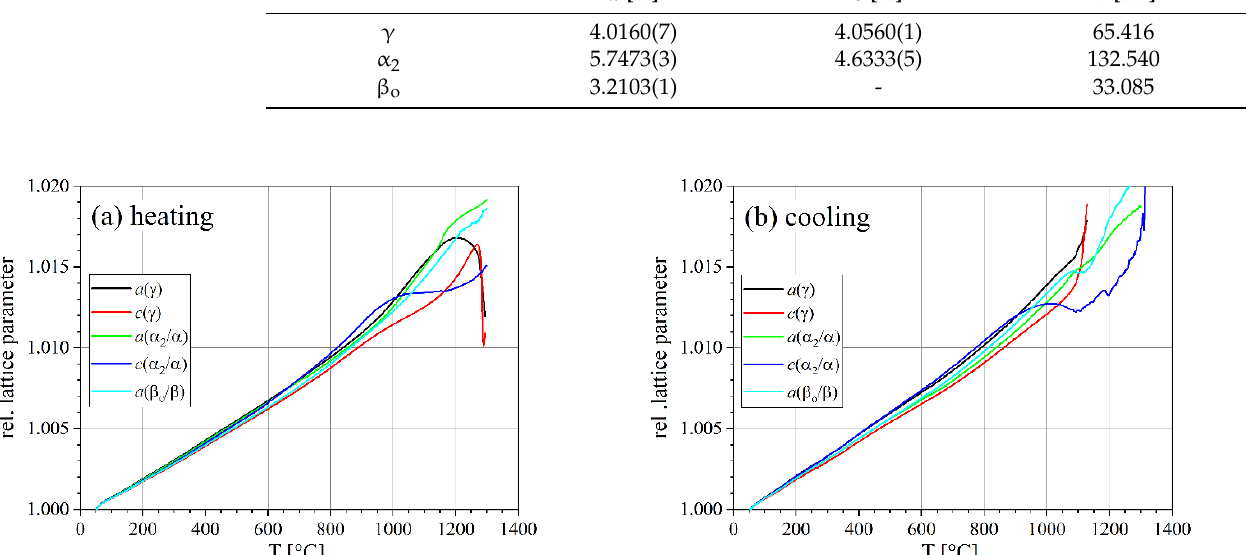
Figure 6. Lattice parameters of the γ , α 2 , and β o phases normalized to the corresponding RT values ( a ) during heating and ( b ) during cooling at a rate of 20 K min –1 .